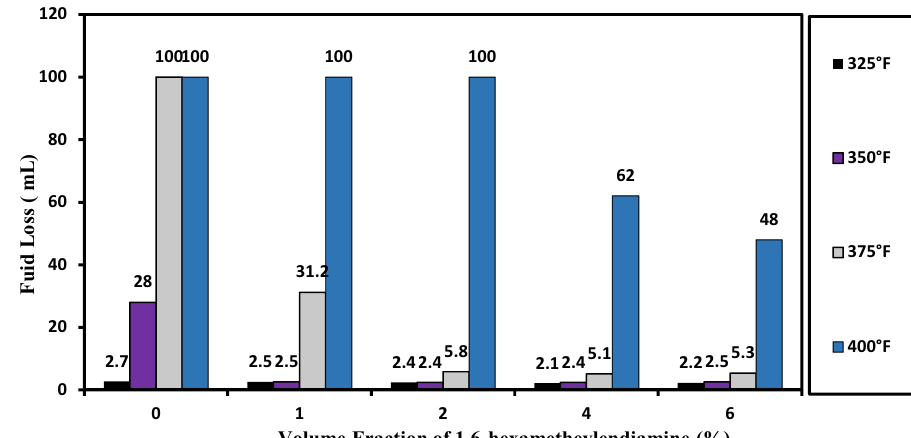
Fig. 6 Effect of the combination of 1,6-hexamethylenediamine and PAC on fluid